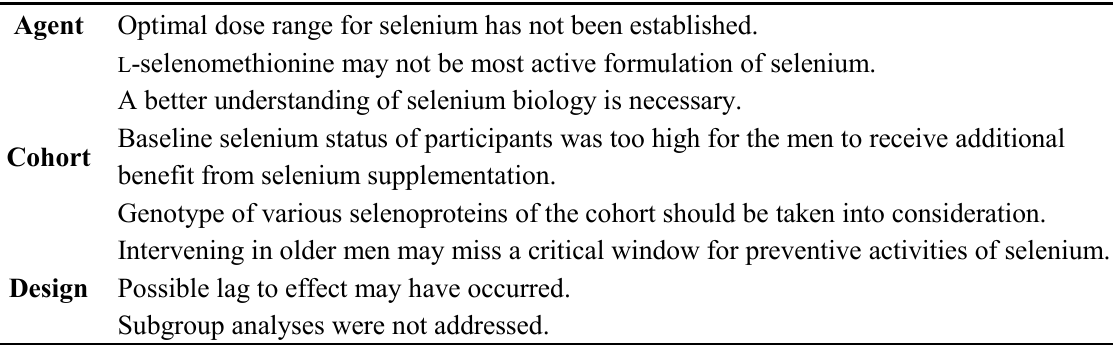
Table 4. Possible explanations for null findings in SELECT with selenium. Agent Optimal dose range for selenium has not been